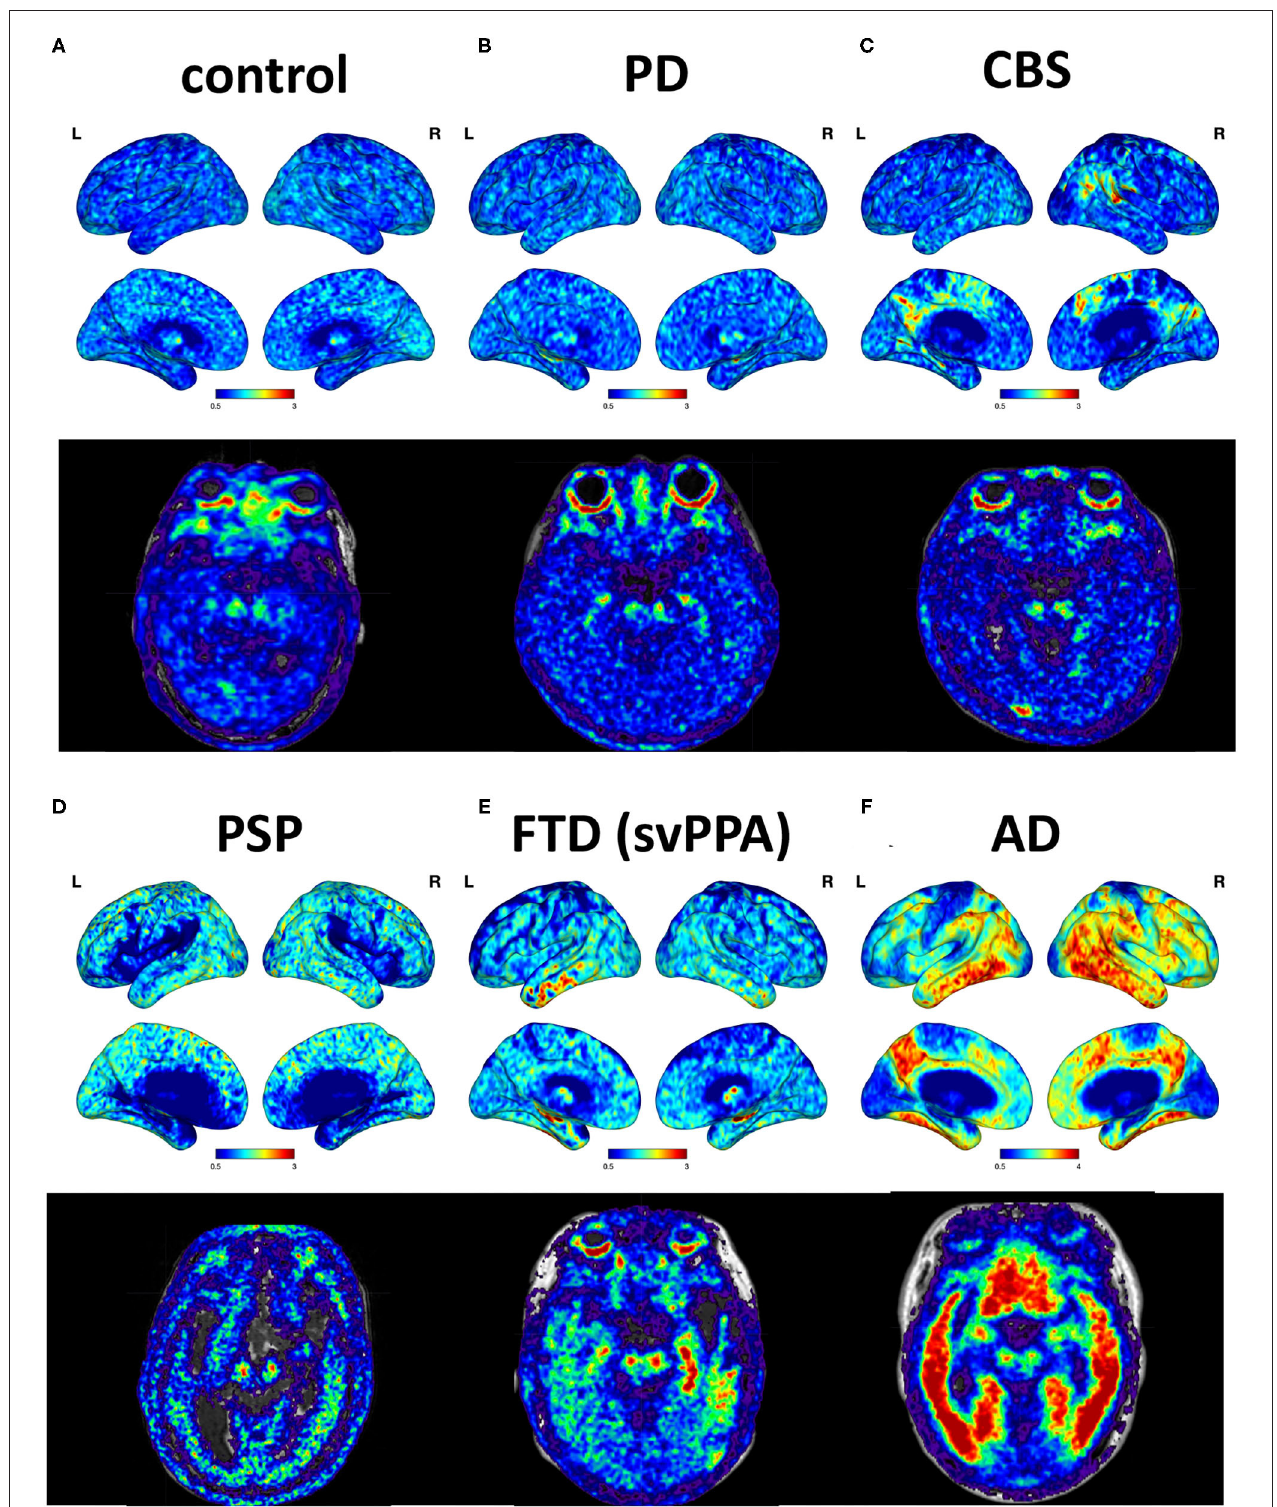
FIGURE 1 | Cortical projections and midbrain axial views of representative subjects. (A) A 69-year-old male with normal neurological assessment. (B) A 57-year-old female with PD (UPDRS III: 28, MMSE: 29). (C) A 38-year-old male with possible CBS (MMSE: 29). (D) A 72-year-old male with PSP-Richardson syndrome (MMSE: 18). (E) A 76-year-old female with FTD, semantic variant PPA subtype (MMSE: 25). (F) A 64-year-old male with AD (MMSE: 16).